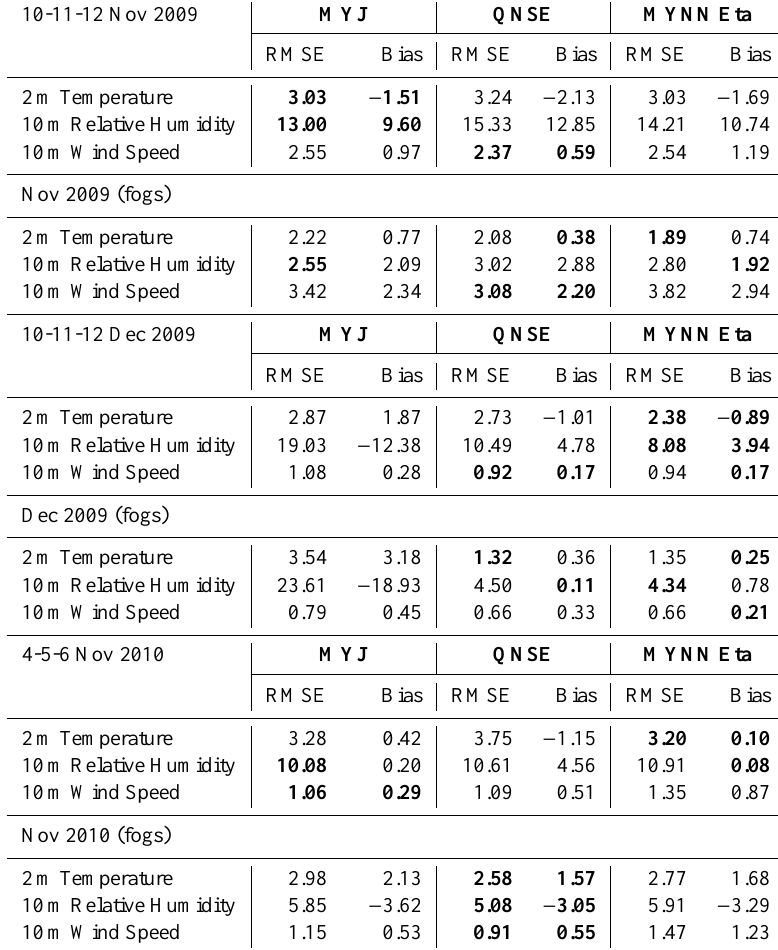
Table 2. RMSE and bias calculated for each period (3 days) and during fog moments (indicated by “fogs”) for di ff erent parameters and for di ff erent PBL parameterizations, MYJ (Mellor-Yamada Janjic), QNSE (Quasi-Normal Scale Elimination) and MYNN Eta (Mellor Yamada Nakanishi and Niino 2.5 level). Lowest values are indicated in